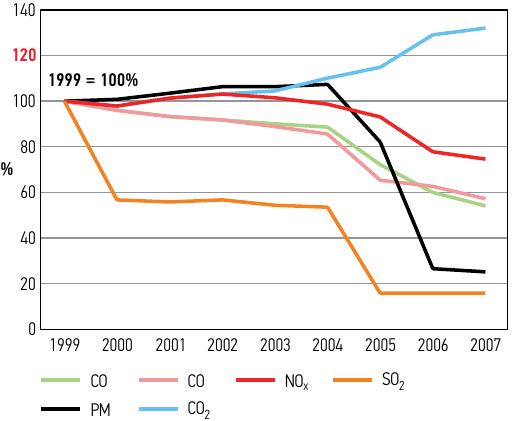
Fig. 1. Transport related emission in